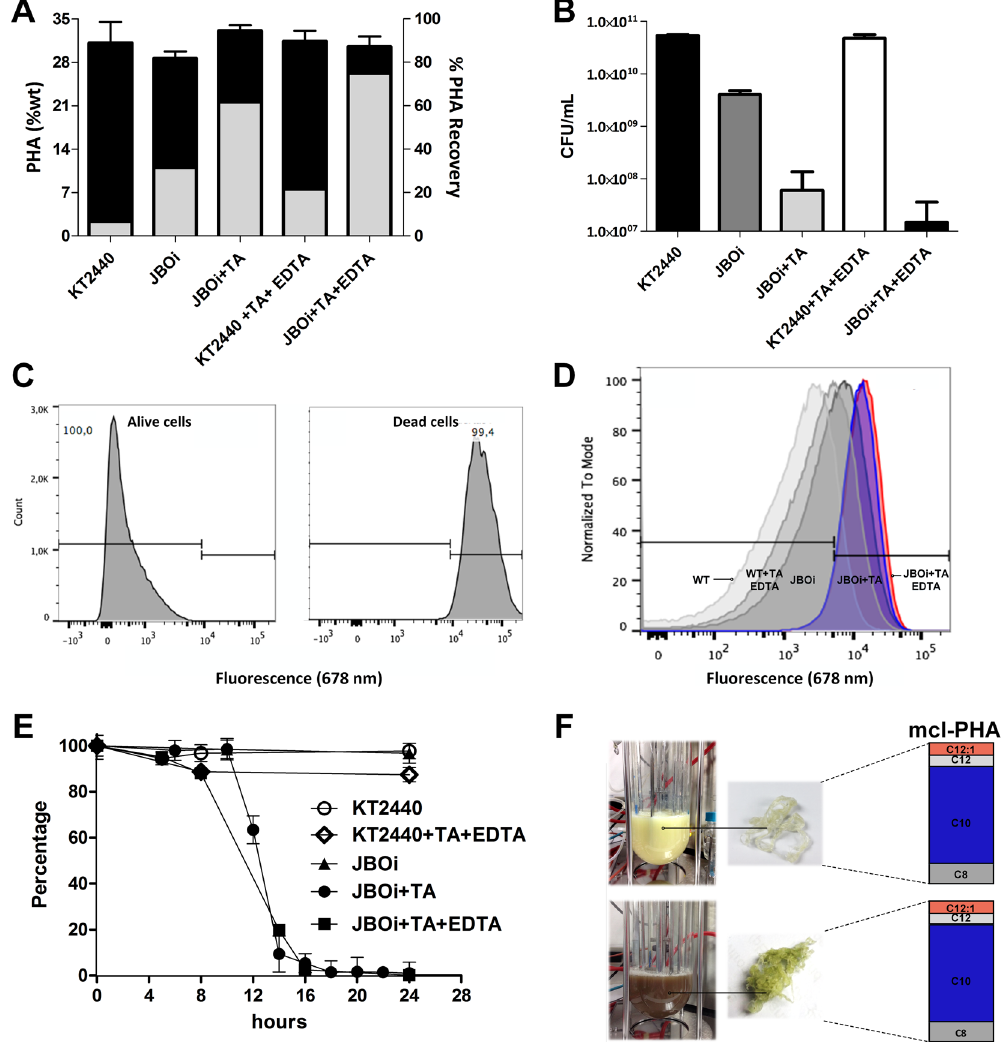
Figure 4. PHA yield and recovery in the recombinant and the wild type P . putida strain ( A ), CFU counts ( B ) and lysis response via FACS ( C , D ) after 96 h of cultivation under PHA-producing conditions in shake flask cultures. Dynamic cell lysis response of the recombinant and the wild type P . putida strain upon induction at 72 h incubation ( E ), and PHA synthesis in bioreactors showing the final monomer composition ( F